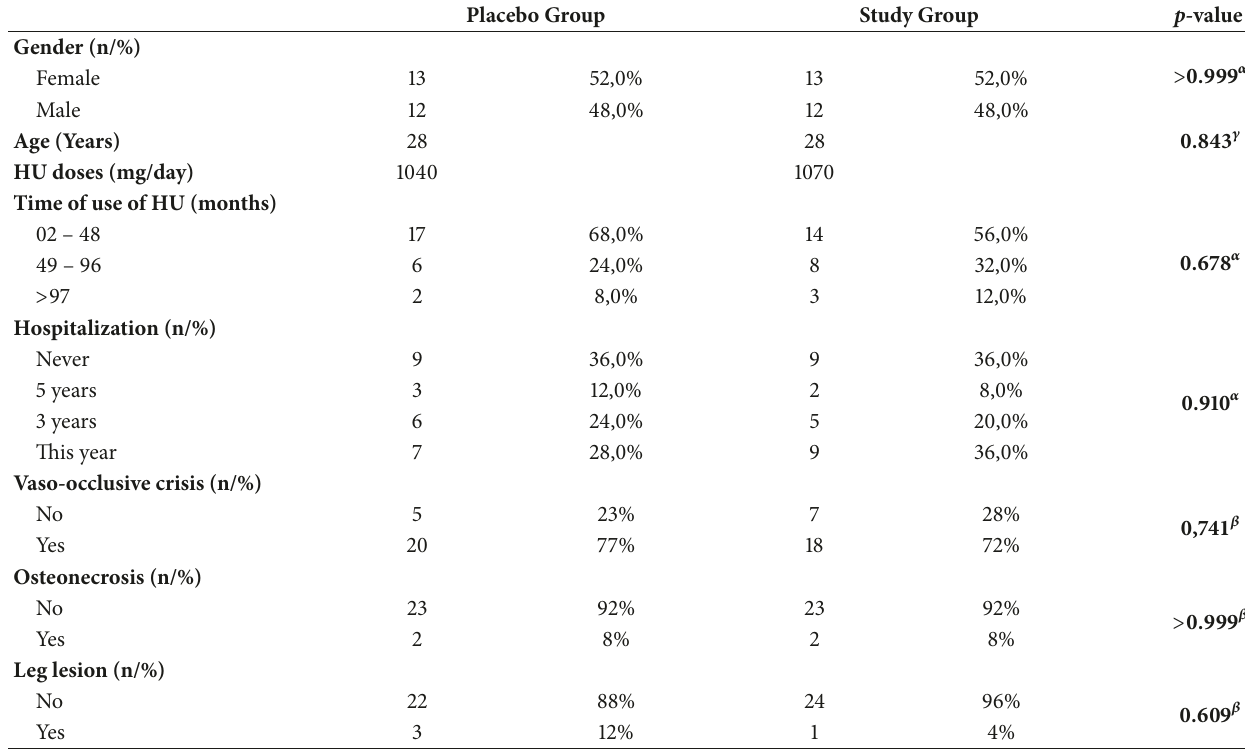
Table 1: Baseline characteristics of the patients.